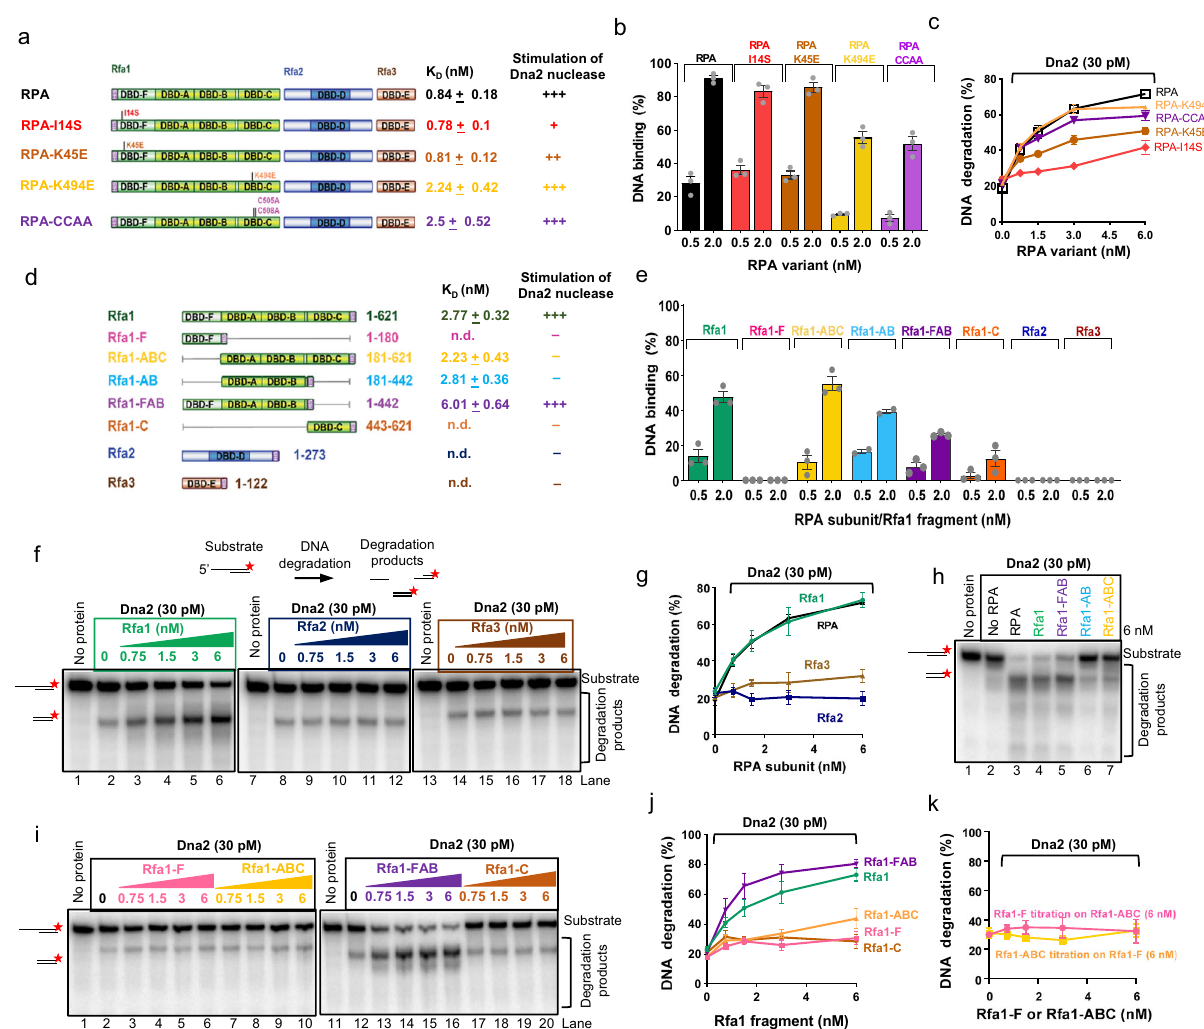
Fig. 3 The DBD-FAB domains of Rfa1 stimulate the Dna2 nuclease. a A scheme of wild type RPA and selected point mutants. K D, concentration of the respective RPA variant resulting in 50% binding of ssDNA (93 nt, 0.1 nM, in molecules) such as shown in Supplementary Fig. 3c, h. Error, SEM; n = 3. The extent of stimulation of the Dna2 nuclease is indicated on the right. b Quantitation of ssDNA (93 nt, 0.1 nM, in molecules) binding by the RPA variants as shown in panel a . Error bars, SEM; n = 3. c Quanti fi cation of nuclease assays with his-tagged RPA wild type and point mutants and Dna2 using 5 ′ - overhanged DNA (45 nt ssDNA, 48 bp dsDNA, 1 nM in molecules). Error bars, SEM; n = 3. d A scheme of RPA subunits and Rfa1 fragments. K D, concentration of the respective variant resulting in 50% binding to ssDNA (93 nt, 0.1 nM, in molecules), such as shown in Supplementary Fig. 3k, l; Error, SEM; n = 3. The extent of stimulation of the Dna2 nuclease is indicated on the right, based on nuclease assays such as shown in panels f and i . e Quantitation of ssDNA (93 nt, 0.1 nM, in molecules) binding by Rfa1 fragments shown in panel d . Error bars, SEM; n = 3. f Representative nuclease assays showing degradation of 5 ′ -overhanged DNA (45 nt ssDNA, 48 bp dsDNA, 1 nM in molecules) by Dna2 and its stimulation by the RPA subunits. The red asterisk indicates the position of the radioactive label. g Quanti fi cation of nuclease assays such as shown in panel f . RPA wild type is replotted as in panel c for reference. Error bars, SEM; n = 3. h Representative nuclease assays as in panel f , but with shorter 5 ′ -overhanged DNA (19 nt ssDNA, 31 bp dsDNA, 1 nM, in molecules) and with 100 mM NaCl. i Representative nuclease assays with Rfa1 fragments and Dna2 using 5 ′ -overhanged DNA (45 nt ssDNA, 45 bp dsDNA, 1 nM, in molecules). j Quanti fi cation of nuclease assays such as shown in panel i . Rfa1 is replotted as in panel g for reference. Error bars, SEM; n = 3. k Quanti fi cation of nuclease assays such as shown in Supplementary Fig. 3m, n. Error bars, SEM; n = 3. RPA-SSL (F11S, I14S, F15L) mutant (Fig. 4d and Supplementary Next, we compared the capacity of wild type RPA and the Fig. 4a). The triple mutations within the RPA heterotrimer were RPA-I14S and RPA-SSL mutants to stimulate Dna2 to cleave 5 ′ - anticipated to exacerbate the effect of I14S. While the RPA-I14S overhanged DNA. The SSL variant was dramatically impaired to mutant bound ssDNA indistinguishably from wild type RPA, the promote the Dna2 nuclease, much more so than RPA-I14S SSL mutant exhibited ~1.6-fold lower ssDNA binding af fi nity (Fig. 4f, g). As described above, Rfa1 alone can stimulate the Dna2 (Fig. 4e and Supplementary Fig. 4b). This reduction of ssDNA nuclease, similarly as heterotrimeric RPA (Fig. 3g). Accordingly, binding was however more subtle than that of the RPA-K494E the I14S mutation within the Rfa1 subunit alone had a similar and RPA-CCAA variants (Fig. 3b, ~3-fold reduction), which did negative effect, comparable to the I14S mutation within the not affect the stimulation of the nuclease. Therefore, the decrease heterotrimer. Rfa1-K494E mutant was able to stimulate the Dna2 in ssDNA binding of RPA-SSL is unlikely to be responsible for nuclease better than the Rfa1-I14S, despite its lower DNA- any potential effects on the stimulation of the Dna2 nuclease. binding capacity (Supplementary Fig. 4c – f), in agreement with NATURE COMMUNICATIONS| (2021) 12:6521